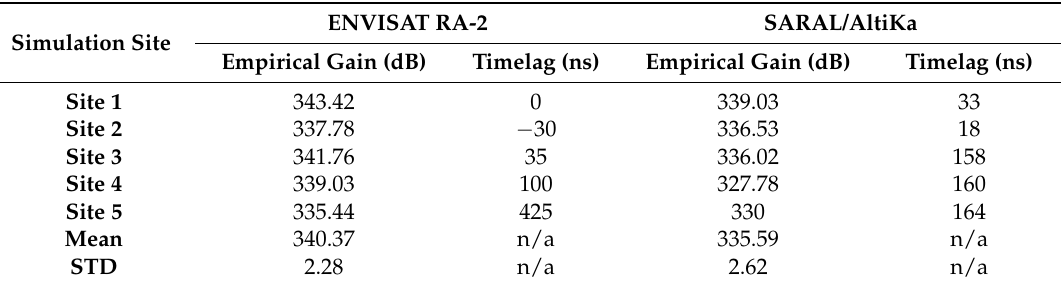
Table A3. Empirical gains and time lags applied to each study site for both ENVISAT RA-2 and SARAL/AltiKa